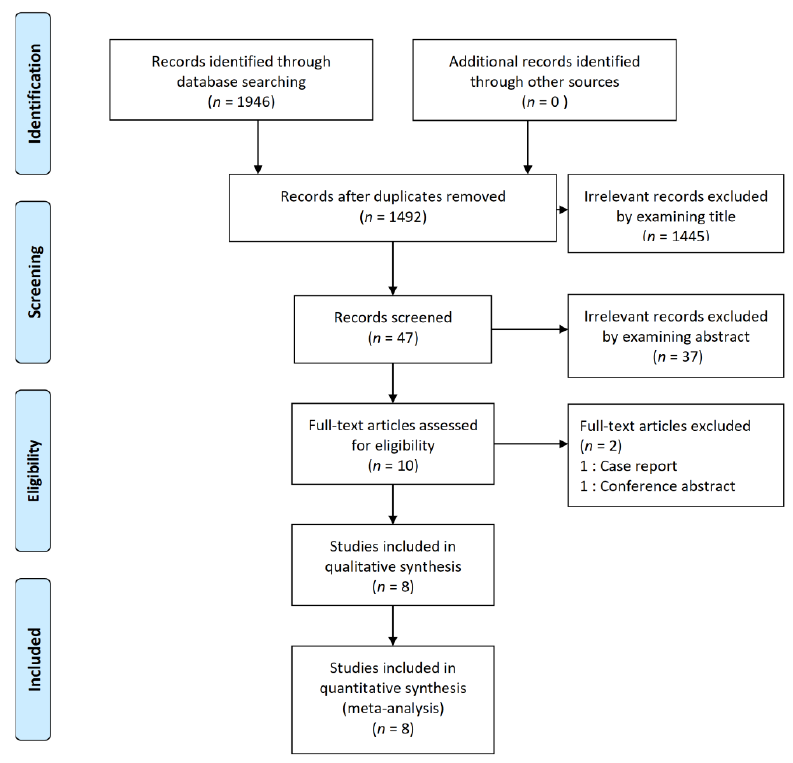
Figure 1. Flow diagram of included and excluded studies.